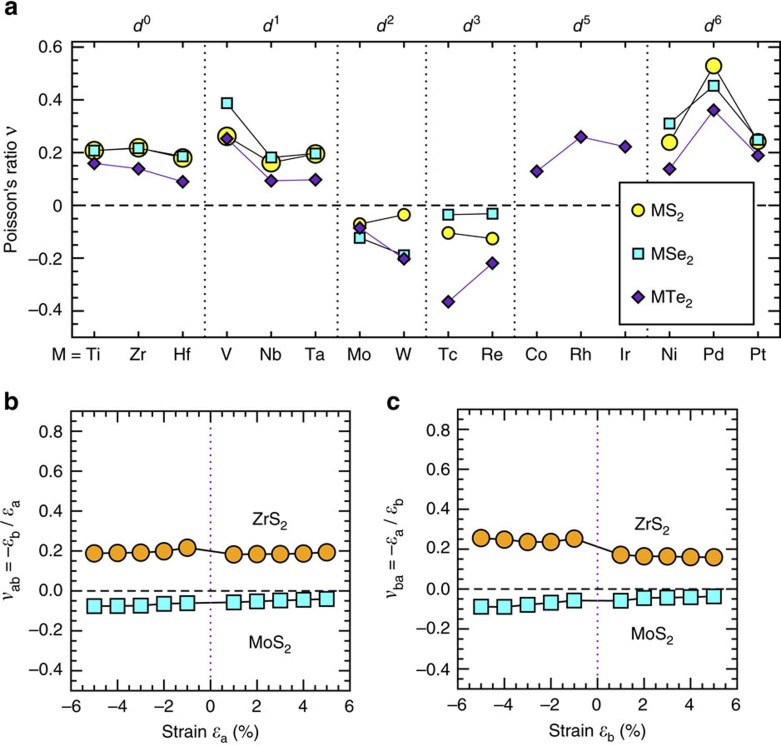
Poisson's ratios.(a) Poisson's ratio, νab=−ɛb/ɛa, calculated for a 5% strain applied along the a axis (that is, ɛa=5%). (b,c) Poisson's ratios for ZrS2 and MoS2 as a function of strain applied along the a axis (b) and b axis (c).